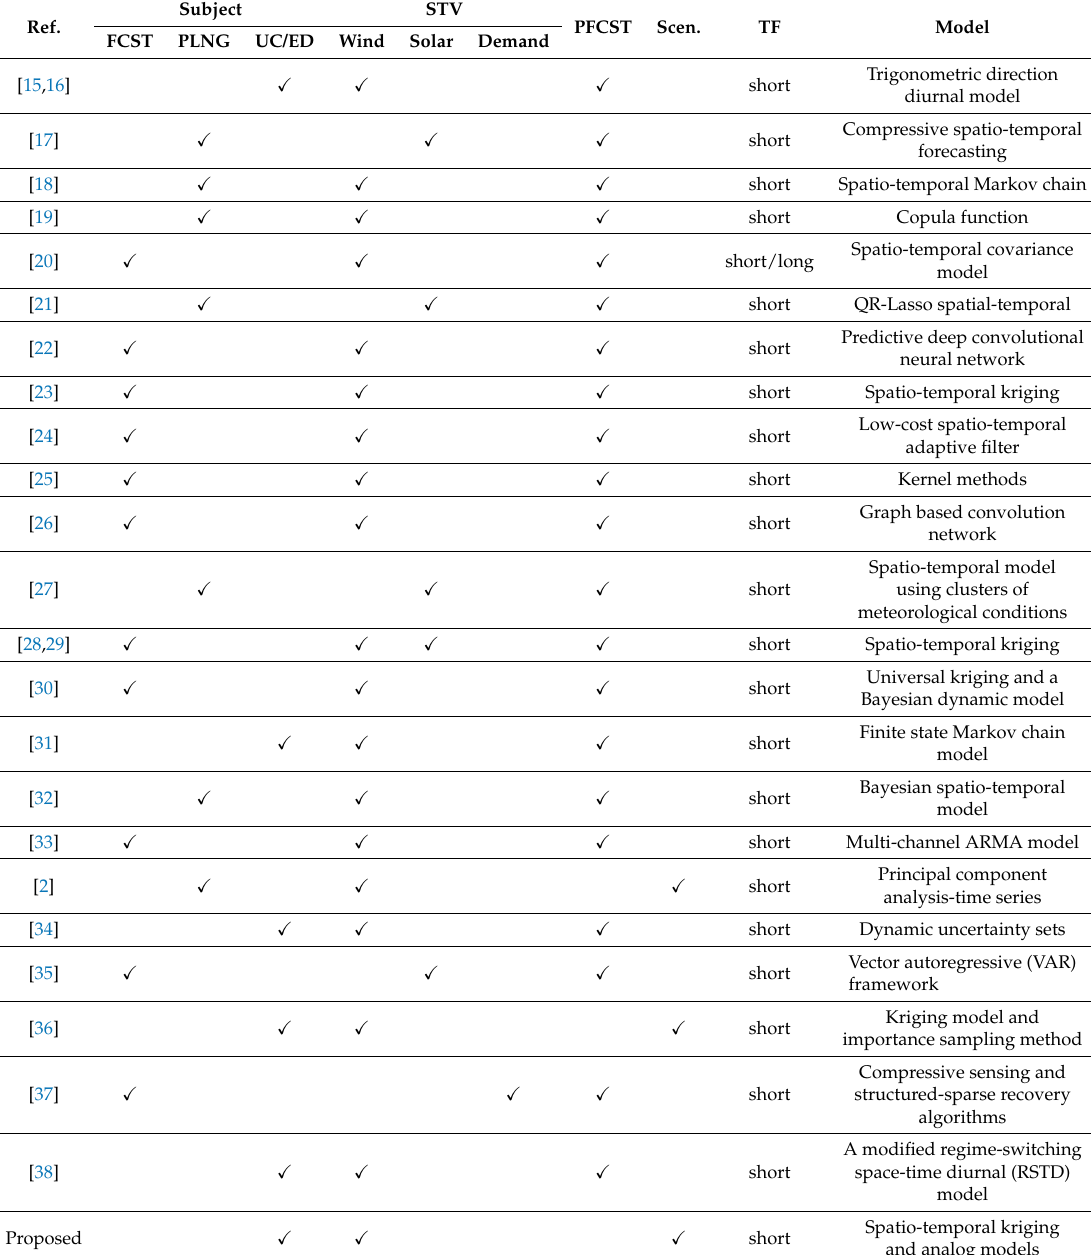
Table 1. Spatial-temporal methods applied to operational planning of power systems. STV, spatial-temporal variable; PFCST, point forecasting; Scen, scenario; TF, time frame; PLNG, power planning